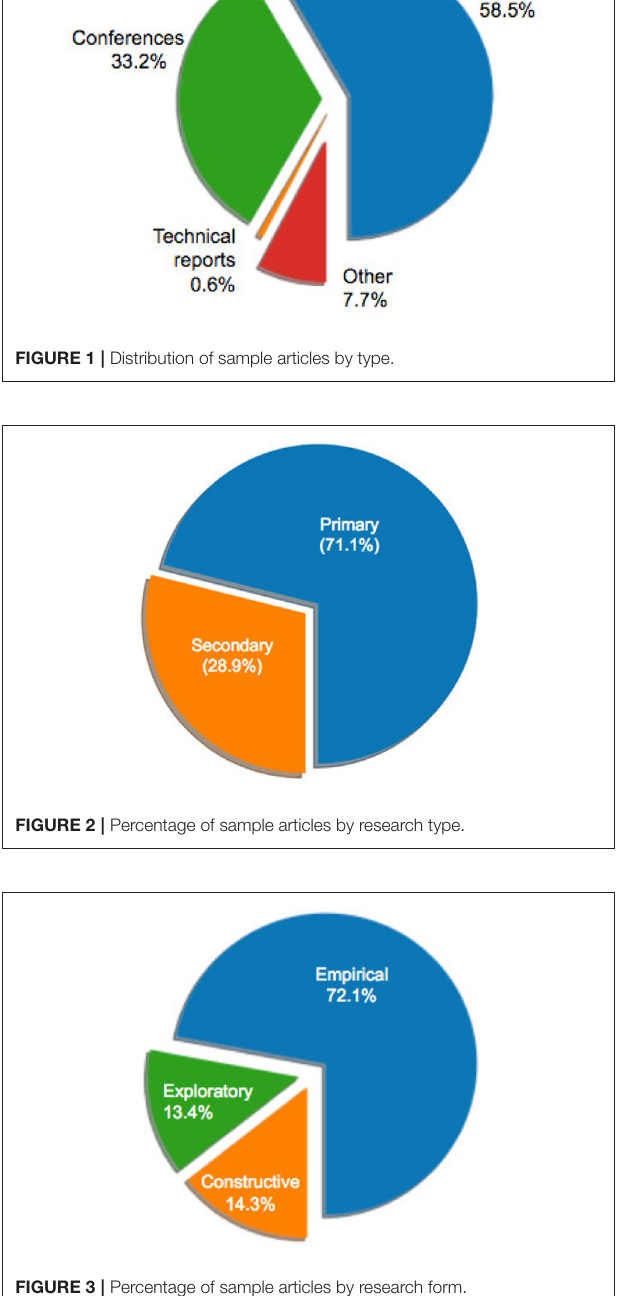
FIGURE 3 | Percentage of sample articles by research